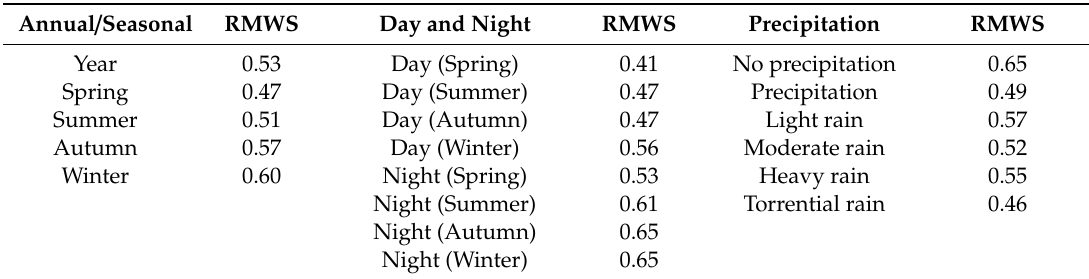
Table 6. Variation in downtown ventilation performance (RMWS: relative mean wind speed) in Shenyang in